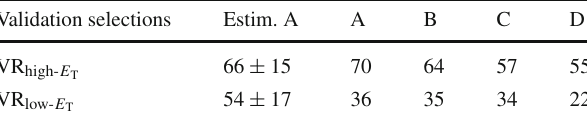
Table 2 Application of the ABCD method to the final high- E T and low- E T VRs. The column labelled “Estim. A” gives the estimated con- tribution of background in the search region A assuming no signal, as calculated using the ABCD method. The statistical uncertainty of this calculation is also given. A, B, C and D show the number of observed events in each region. Only statistical uncertainties are considered in this